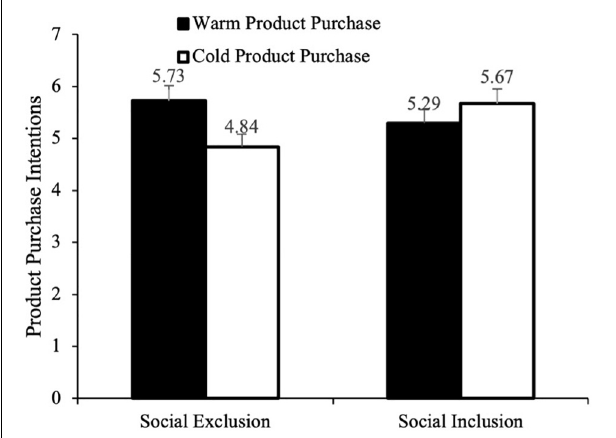
FIGURE 3 | The interaction of social exclusion and warm and cold color’s type (Study